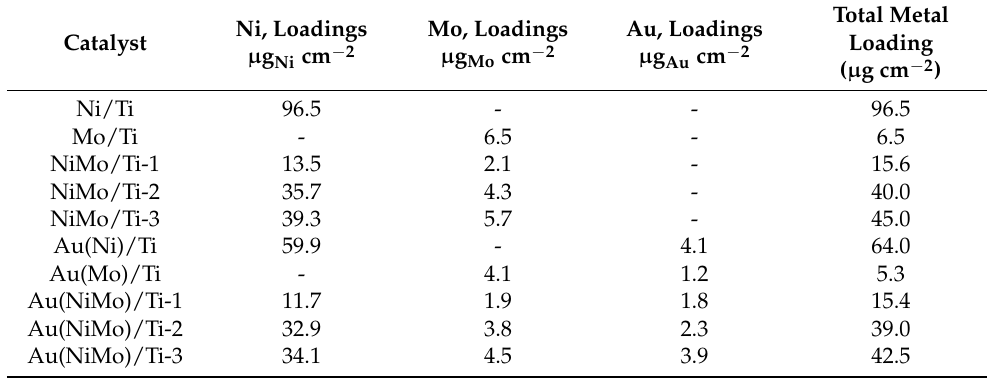
Figure 2. SEM images of NiMo/Ti-1 ( a ), NiMo/Ti-2 ( b ), NiMo/Ti-3 ( c ), Au(NiMo)/Ti-1 ( d ), Au(NiMo)/Ti-2 ( e ), and Au(NiMo)/Ti-3 ( f ) coatings. Table 1. The composition of coatings by ICP-OES.